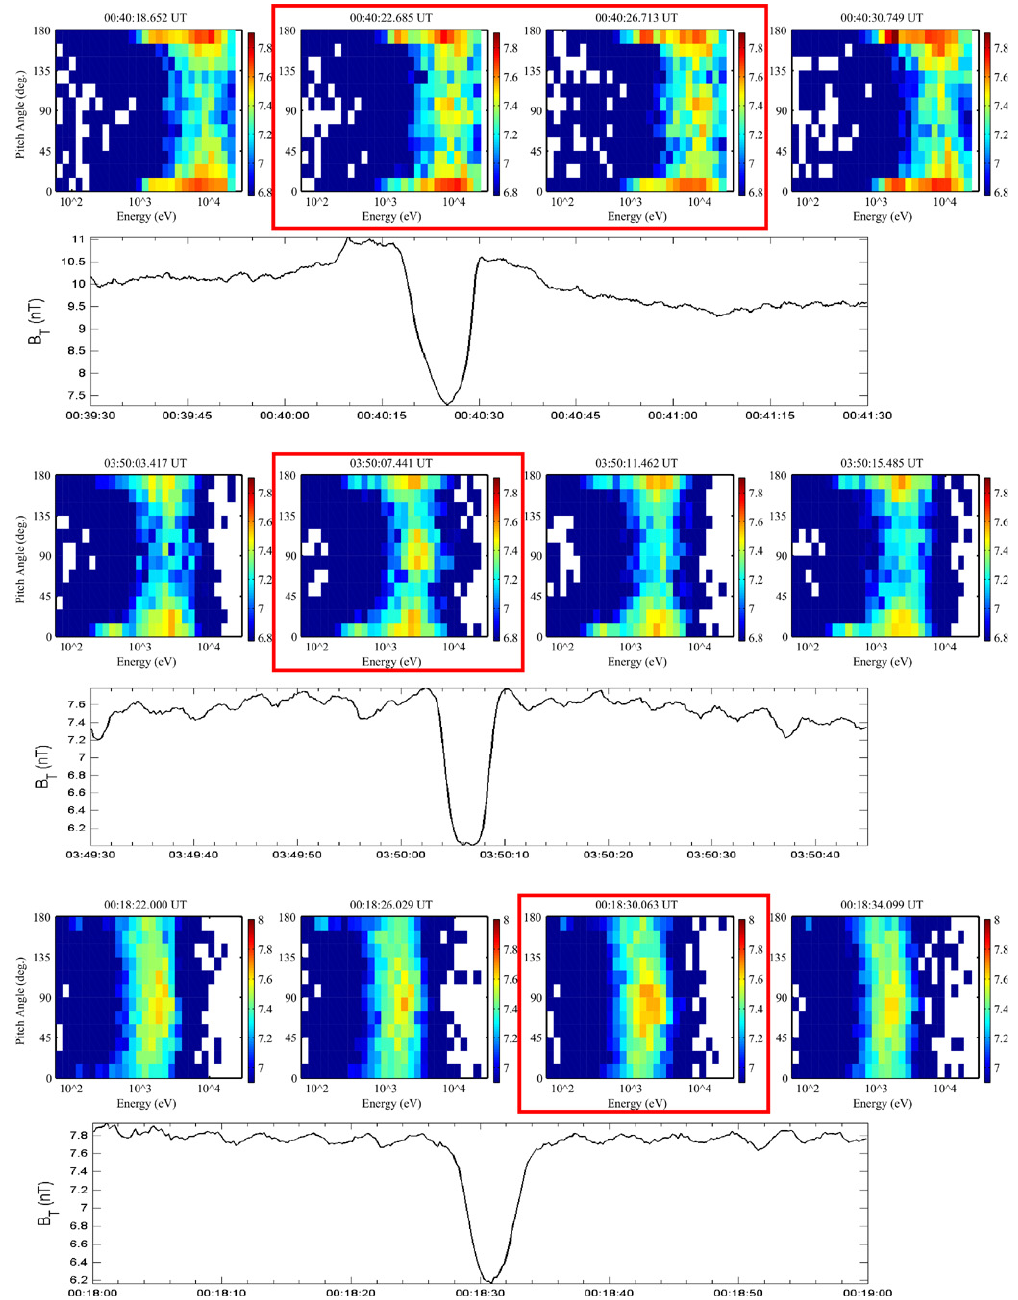
Fig. 5. Electron energy flux (unit log keVcm − 2 s − 1 sr − 1 keV − 1 ) obtained by Plasma Electron and Current Experiment (PEACE) as a function of pitch angle and energy and the related magnetic holes. The pitch angle distributions inside red frames are the distributions inside magnetic